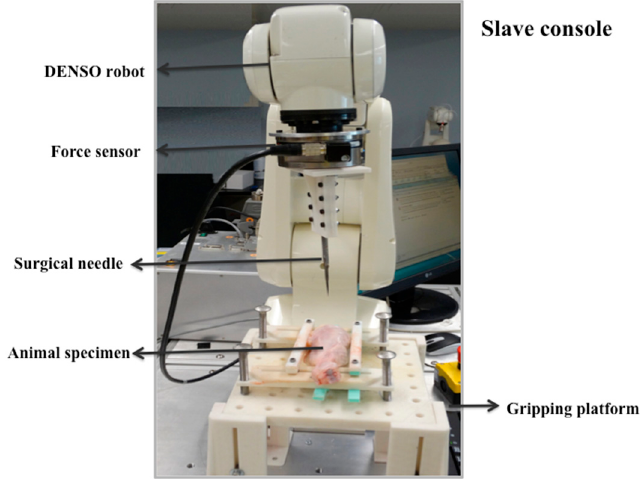
Figure 1. Slave console comprising a DENSO robot, force sensor, surgical needle, animal tissue, and gripping platform.